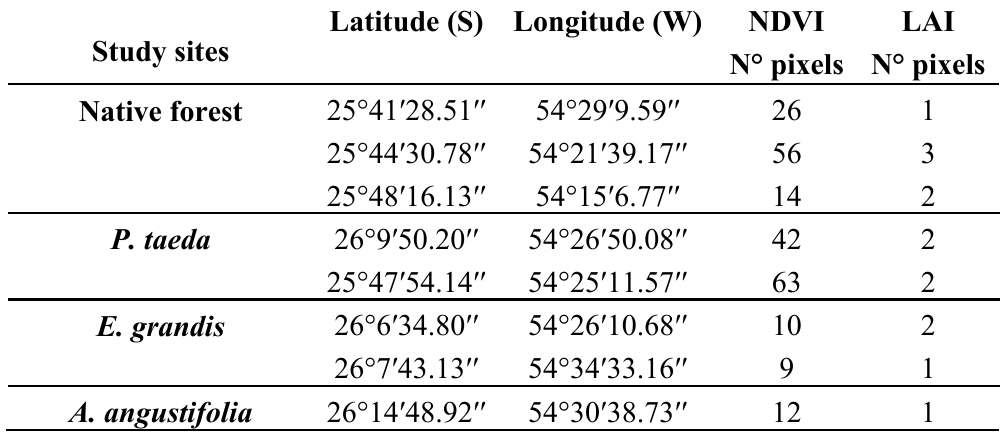
Table 2. Central geographic coordinate and number of pixels used to characterize NDVI (Normalized Difference Vegetation Index) and LAI (Leaf Area Index) in each study site from the MODIS-Terra